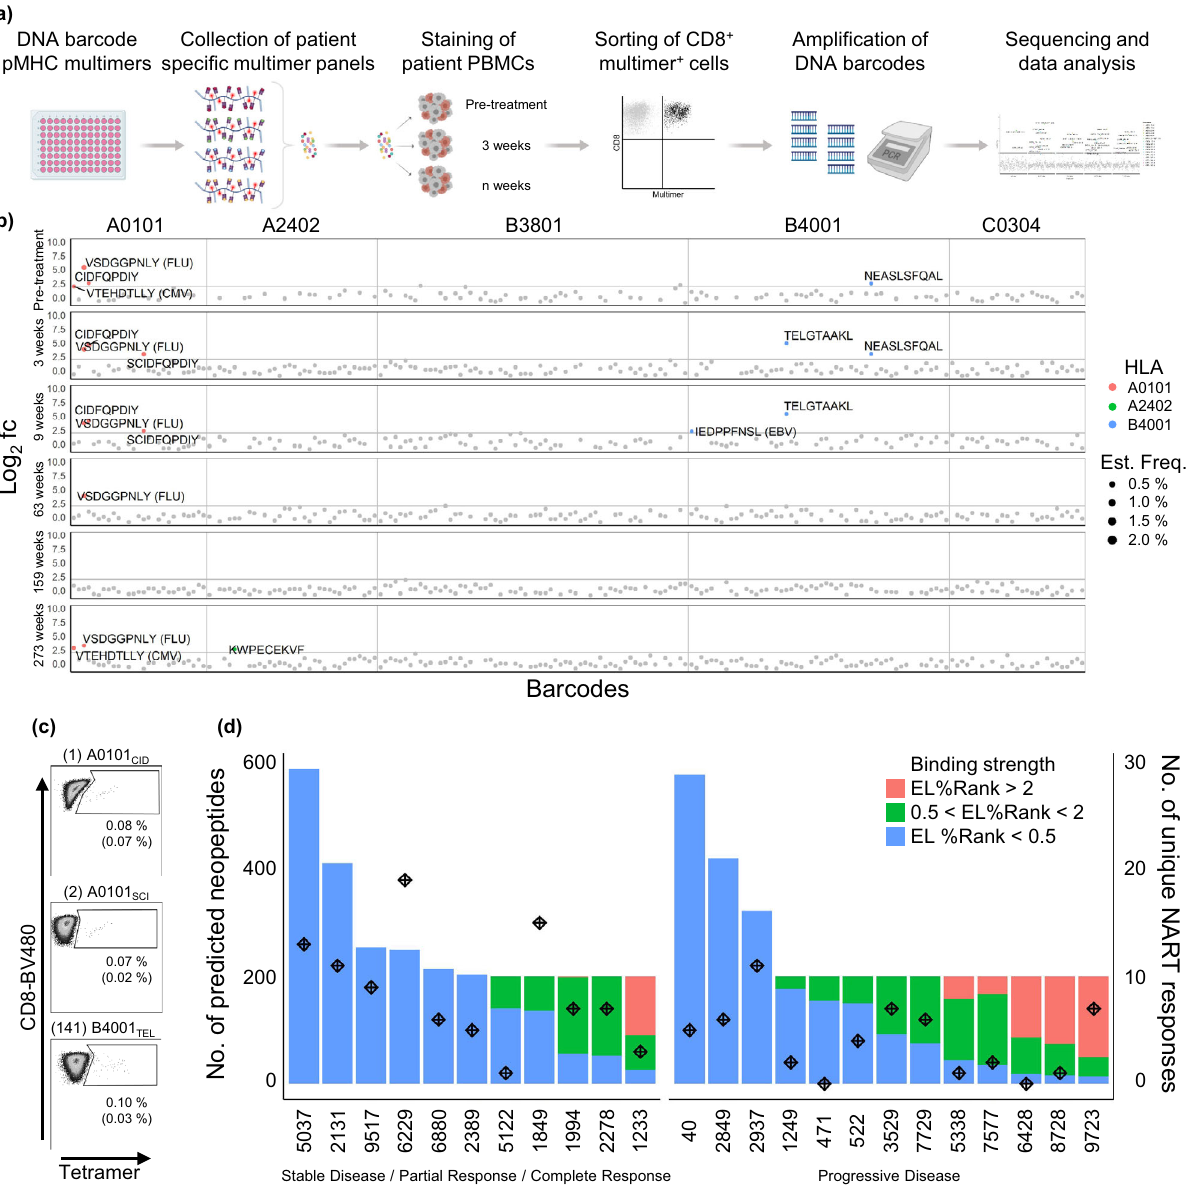
Fig. 2 Detection of neoepitope-reactive T cell responses in mUC cancer patients. a Overview of work fl ow for detection of neoantigen speci fi c T cells in mUC cancer patients. Experimental steps include building of DNA-barcoded pMHC multimer libraries from predicted neopeptides, collection of multimer panels, staining of patient PBMCs with multimers, sorting of multimer-binding CD8 + T cells, ampli fi cation and sequencing of DNA barcodes, and data analysis. Created with BioRender.com. b Representative output from patient #2389, screening of detected NART responses. Log 2 fold change (fc) of sequenced pMHC associated barcodes enriched by T cell sorting over the input library at each timepoint: pre-treatment, three weeks, nine weeks, 63 weeks, 159 weeks and at 273 weeks post-treatment. Labelled points represent signi fi cantly enriched pMHC co-attached barcodes with Log 2 fc >2, count fraction >0.1% and p < 0.001, determined as T cell responses, among the sorted multimer positive CD8 + T cell populations. T cell responses are colored based on peptide-presenting HLA-type, text labelled with peptide sequence, and sized according the estimated frequency of the peptide-recognizing T cell population. If the peptide is derived from a virus, the virus is annotated in brackets, otherwise it is a mutation-derived neopeptide. Grey points represent non-enriched barcodes. Horizontal line at Log 2 fc = 2. Vertical line separating peptide-presenting HLA-types. c Tetramer validations of three NART responses in patient #2389 at 9-weeks post-treatment. CD8 + cells shown, gated for tetramer + populations. Frequency of tetramer pMHC population given in percentage, together with estimated frequency derived from multimer screening given in brackets. d Library sizes of predicted HLA-I-feasible neopeptides per patient, colored bars according to predicted HLA-I binding strength, compared to total no. of unique NART responses across screened samples for each patient (stars). Source data are provided as a Source Data fi signatures from the UMAP, the frequency of the parameters that evaluated time-points, based on the full dataset. We observed appeared increased in disease control patients post-treatment, i.e. an increase in the frequency of Ki67 + (bulk CD8 p = 0.00034, NARTs p = 0.0054, VARTs p = 0.001) and PD-1 + (bulk CD8 KI67, CD39 and PD-1, were quanti fi ed for ‘ bulk CD8 T cells ’ , ‘ NARTs ’ , and ‘ VARTs ’ in the individual patients and the p = 0.041, NARTs p = 0.043) CD8 T cells from baseline to three